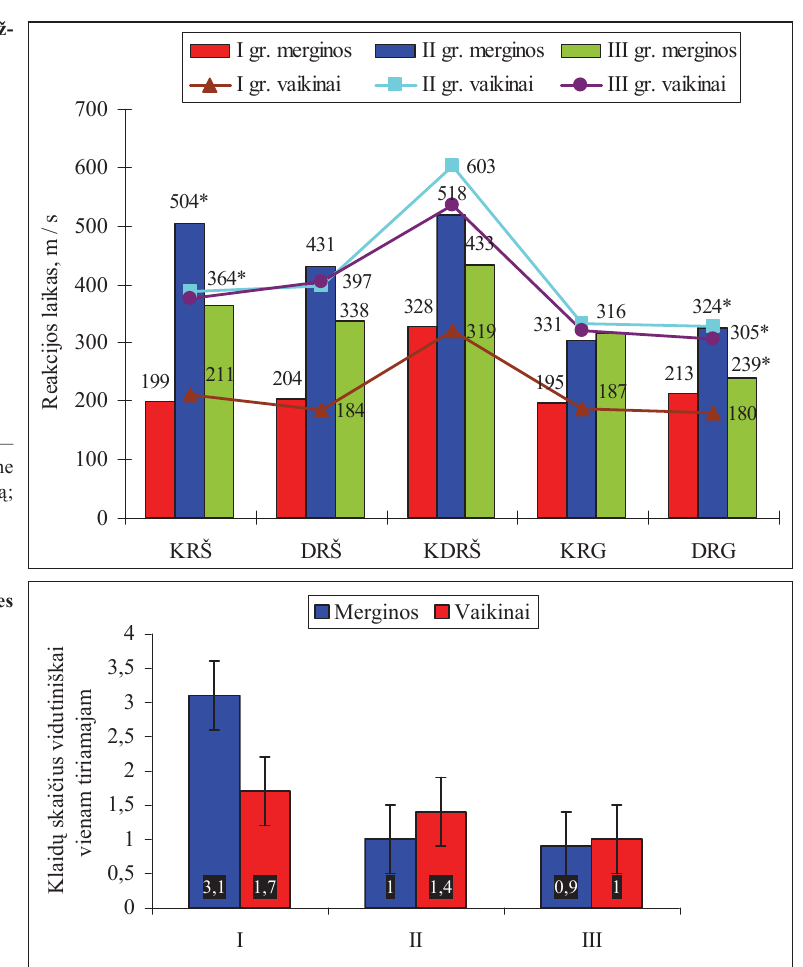
skirtumo nepasteb ė ta, nors III grup ė s vidutiniškai protiškai atsilikusi ų vaikin ų reakcija į gars ą šiek tiek greitesn ė nei II grup ė s nežymiai protiškai atsi- likusi ų vaikin ų . II ir III grup ė s sutrikusio